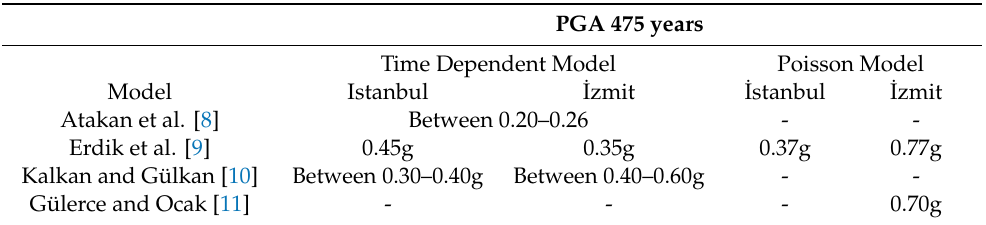
Table 1. Comparison of the 475-year PGA estimations by previous